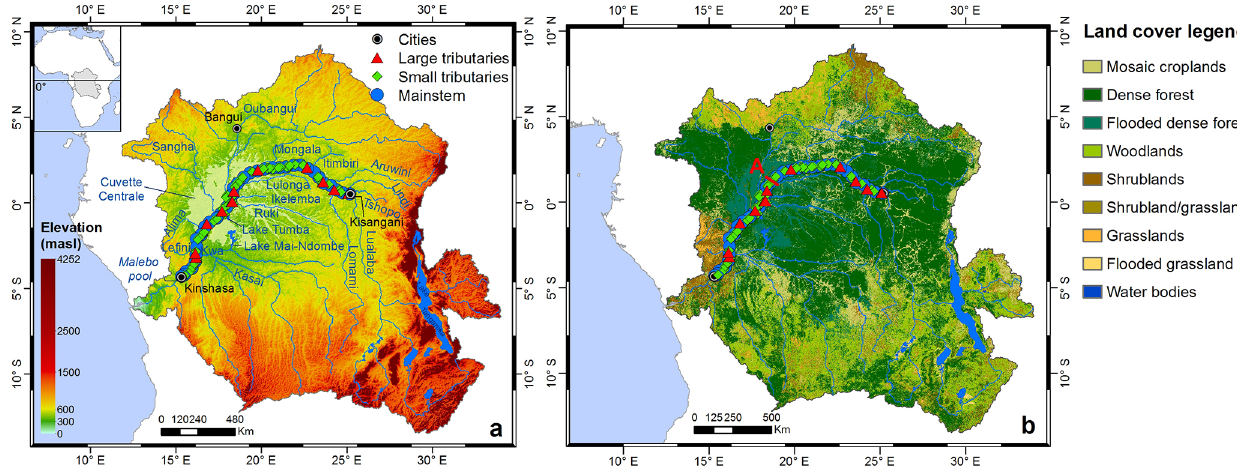
Figure 1. Maps of the Congo Basin. (a) The elevation (Lehner et al., 2008), the main hydrological network, the extent of the Cuvette Centrale (Lehner and Döll, 2004), and the distribution of sampling sites along the Kisangani–Kinshasa transect. (b) The dominant land cover (Bontemps et al., 2011). The red line “A” indicates the entrance of the Congo River within the core of the Cuvette Centrale (see text for details and Fig. S1).